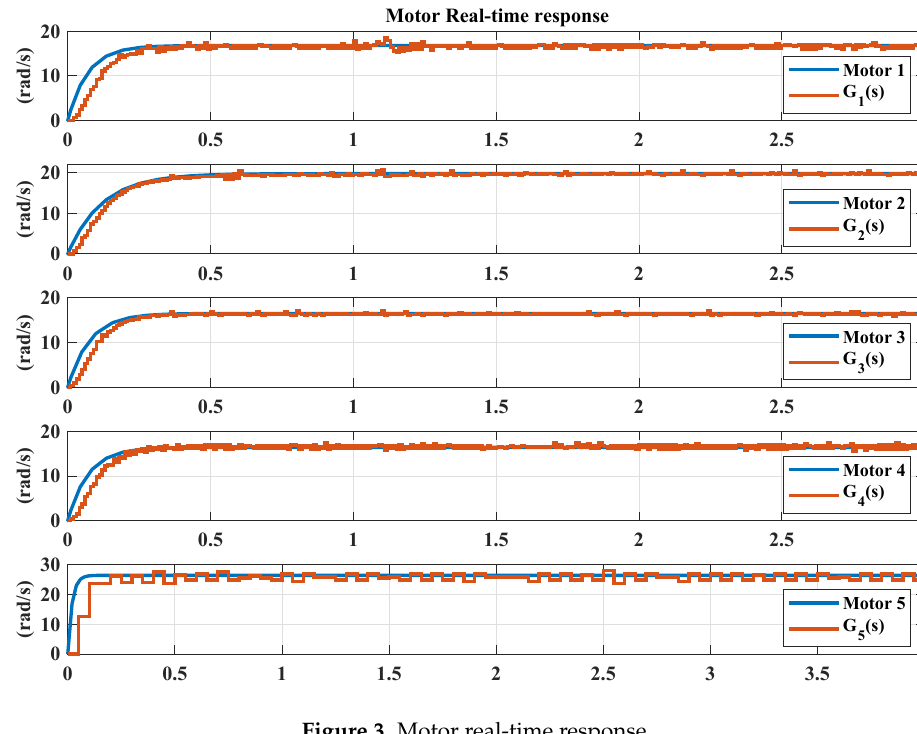
Figure 3. Motor real-time